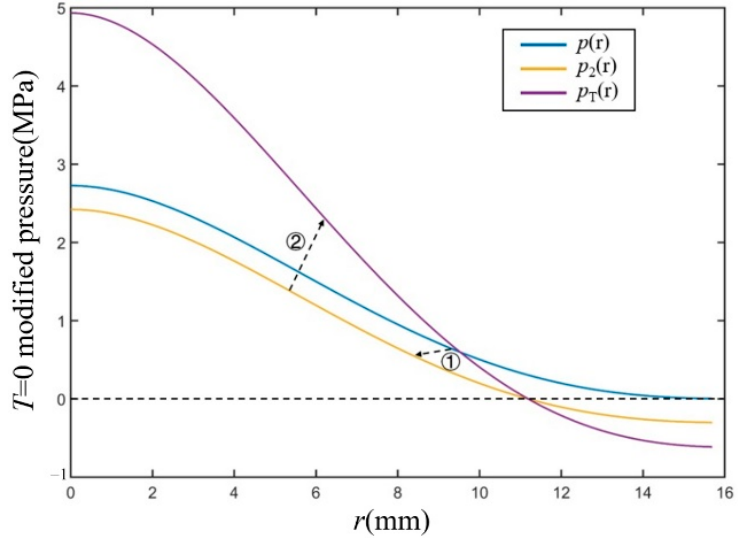
= = Figure 7. Pressure distribution curves ( T = 0 N, n = 3 ). 1 (cid:13) represents the correction for consistency; Figure 7. Pressure distribution curves 0N T , 3 n ). ① represents the correction for consistency; 2 (cid:13) represents the correction for preload. ② represents the correction for preload. Through finite element calculation, microslip occurs when T ≥ 554 N. Therefore, T ≥ 554 N is the solution interval of the dynamic Iwan model. Taking T = 554 as an example, the semi-major axis, the semi-minor axis and the corresponding area of the discrete area can be deduced, as shown in Table 4. Table 4. Geometric parameters of discrete areas ( T = 554 N, n = 3).